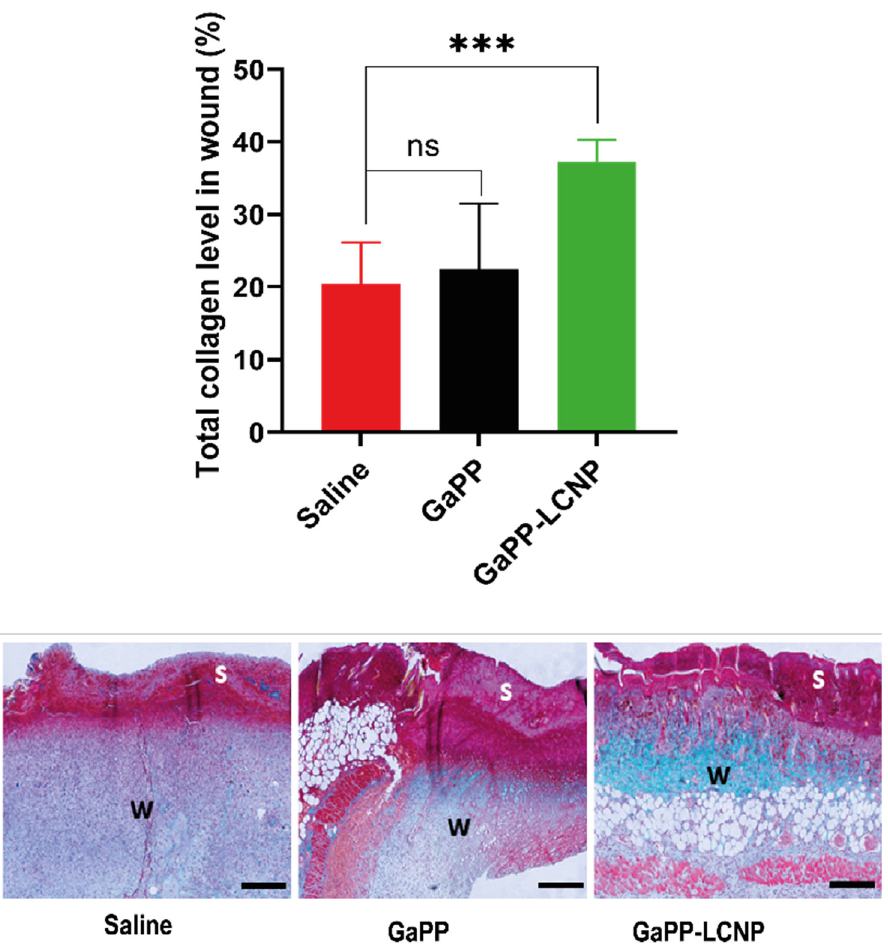
Figure 12. Graphical analysis and representative images of early total collagen deposition in wounds at day six of the in vivo study. The images demonstrate total collagen deposition (green color) in wound bed (w) below the wound scab (s). Data presented as mean ± SD compared to control infected group treated with saline; ns: non-significant, *** p = 0.0007 (one-way ANOVA test followed by multiple comparison Dunnett’s test).